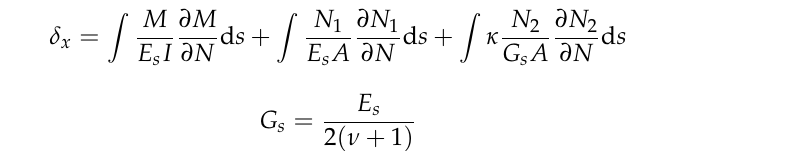
where the section moment of inertia of the honeycomb wall is expressed by I = bt 3 /12, the shear stress shape coefficient of the rectangular section κ is 1.2, d s = d x /cos ϕ . The average strain in the x -direction can be expressed as: